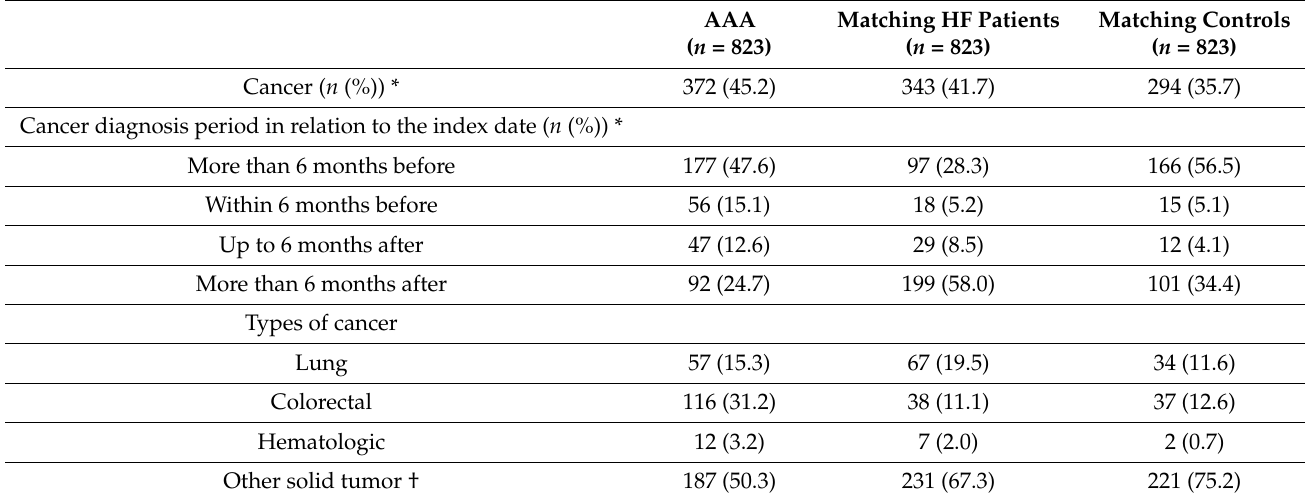
Table 2. Cancer diagnosis period in relation to the index date in each